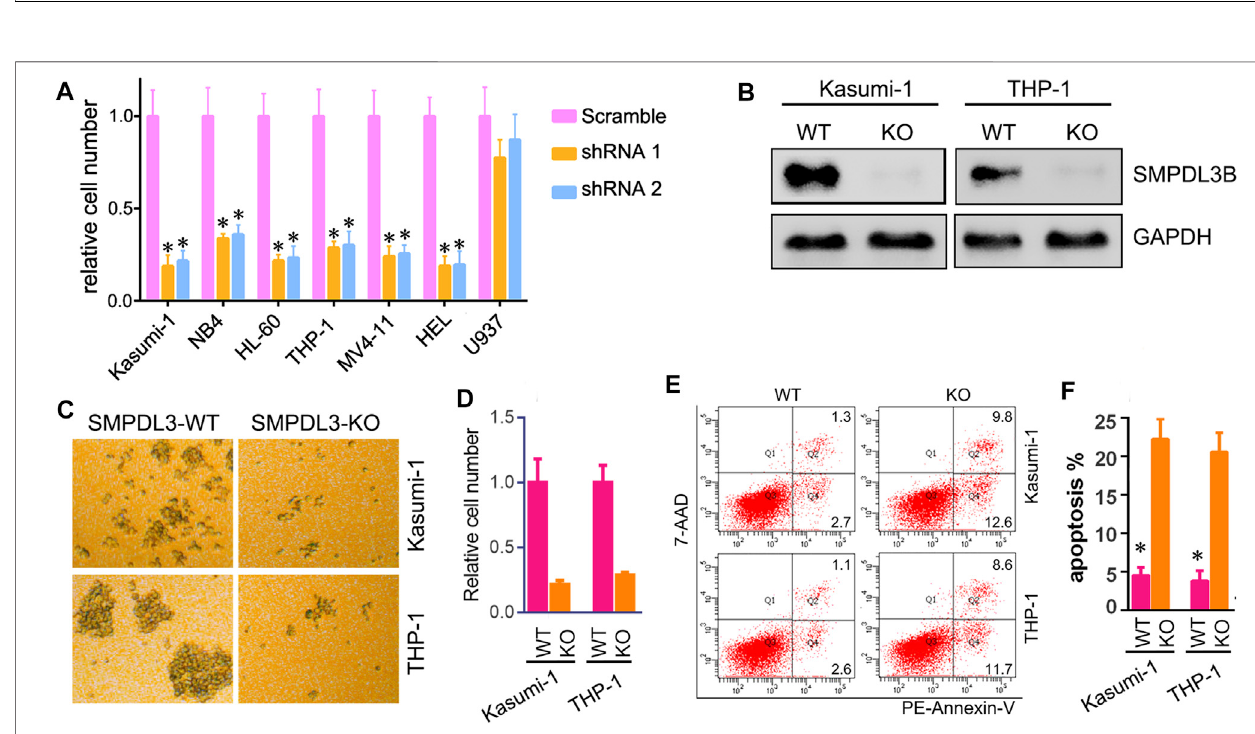
FIGURE 4 | Inhibition of SMPDL3B suppressed growth and promoted apoptosis of AML cells. (A) The indicated AML cells were infected with Scramble or SMPDL3B shRNA lentivirus. The cell numbers were counted at 4 days after infection. The relative cell number is plotted. n (cid:1) 5, * p < 0.001 compared to the Scramble group. (B) Western blot analysis of the expression of SMPDL3B in CRISPR/Cas9-edited AML cells. (C) Representative images of Kasumi-1 and THP-1 cells with wild type(WT)orknockout(KO)SMPDL3B. (D) TheindicatedSMPDL3B-WTorKOcellswereseededin24-wellplate.Cellnumberswerecountedat4 daysafterbeing seeded. The relative cell number is plotted. n (cid:1) 5, p < 0.001 compared to WT group. (E) Representative scatter plots showing apoptosis in SMPDL3B-WT and SMPDL3B-KO AML cells by annexin V-PE and 7-AAD staining and fl ow cytometry. (F) Quanti fi cation of the apoptotic cells. n (cid:1) 3, * p < 0.001 SMPDL3B-WT vs.